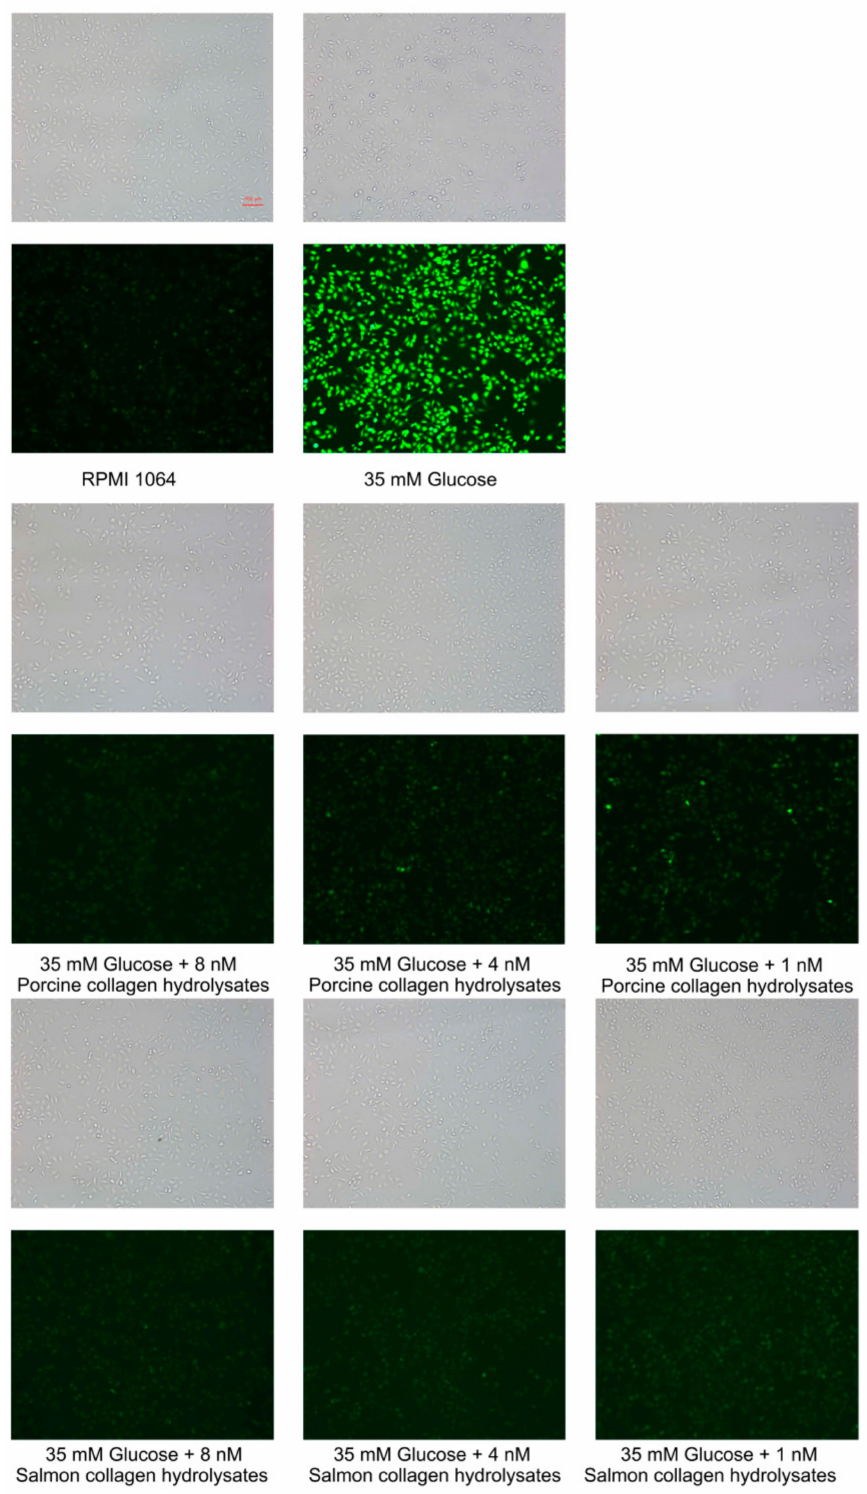
Figure 10. Intracellular reactive oxygen species (ROS) in human umbilical vein endothelial cells (HUVECs) are indicated as green fluorescence by 2,7-dichlorofluorescin diacetate